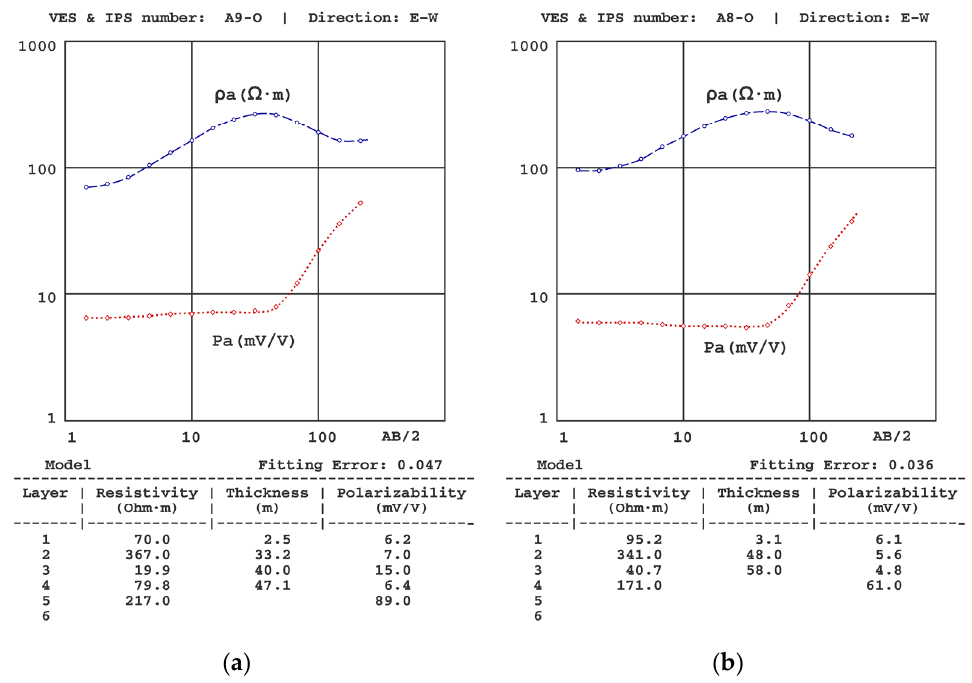
Figure 9. Results of the ( a ) A9-O VES-IPS and ( b ) A8-O VES-IPS were both obtained mid-autumn, showing a clear differentiation of the geoelectric levels and an apparent uncertainty of the values of the deeper